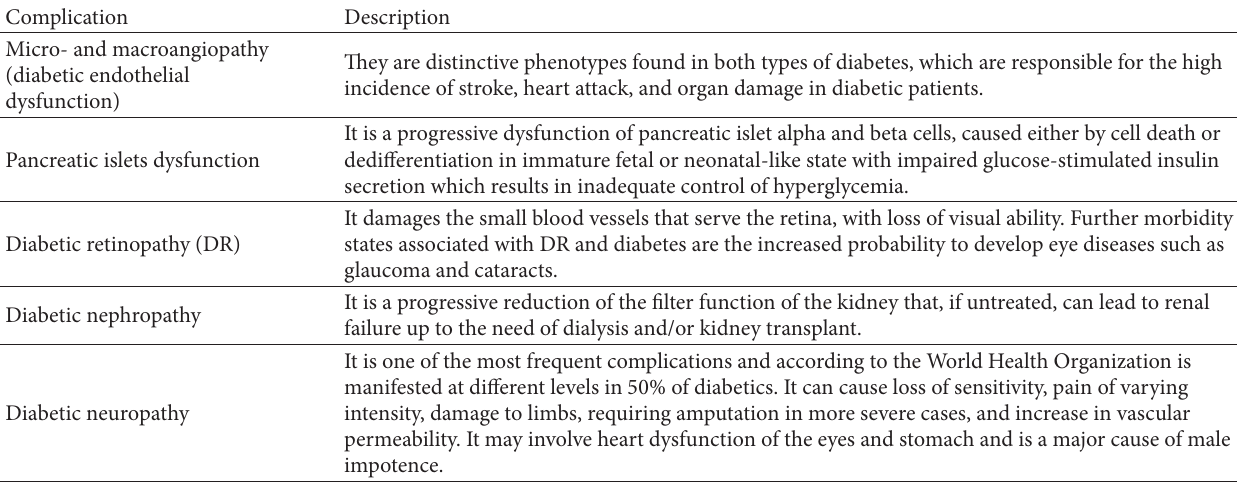
Table 1: Main complications associated with longstanding